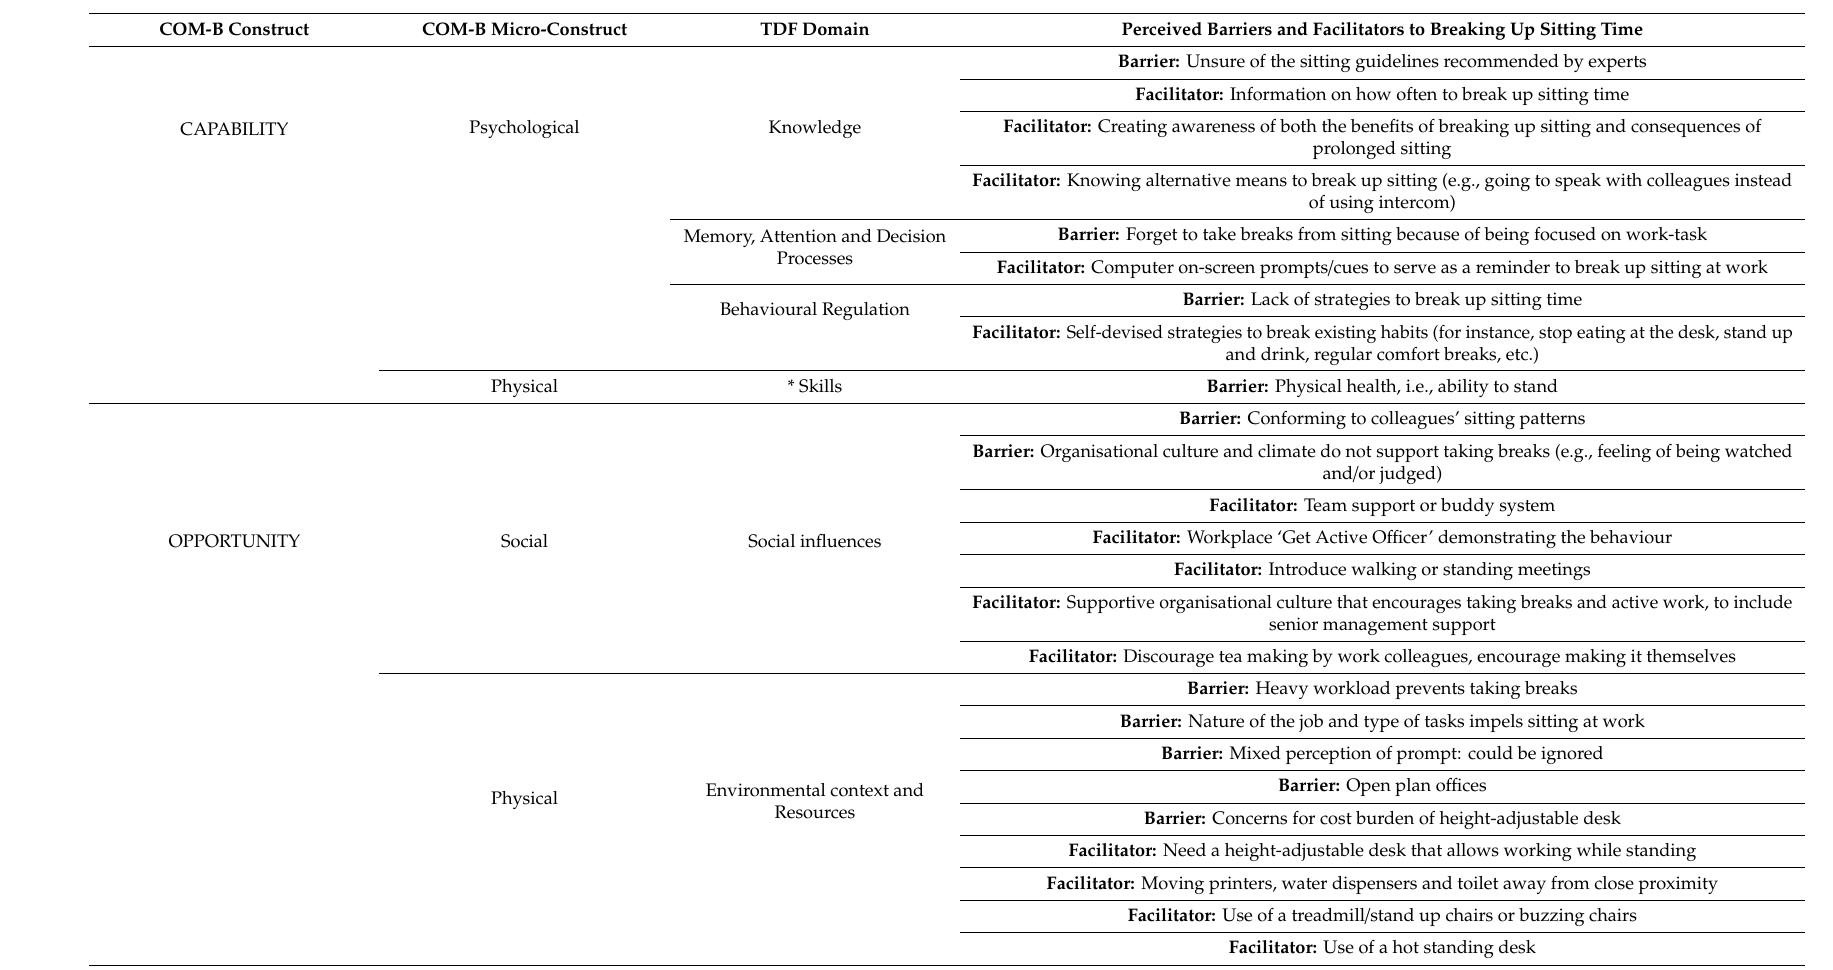
Table 2. Combined COM-B and TDF analysis of the determinants of breaking up